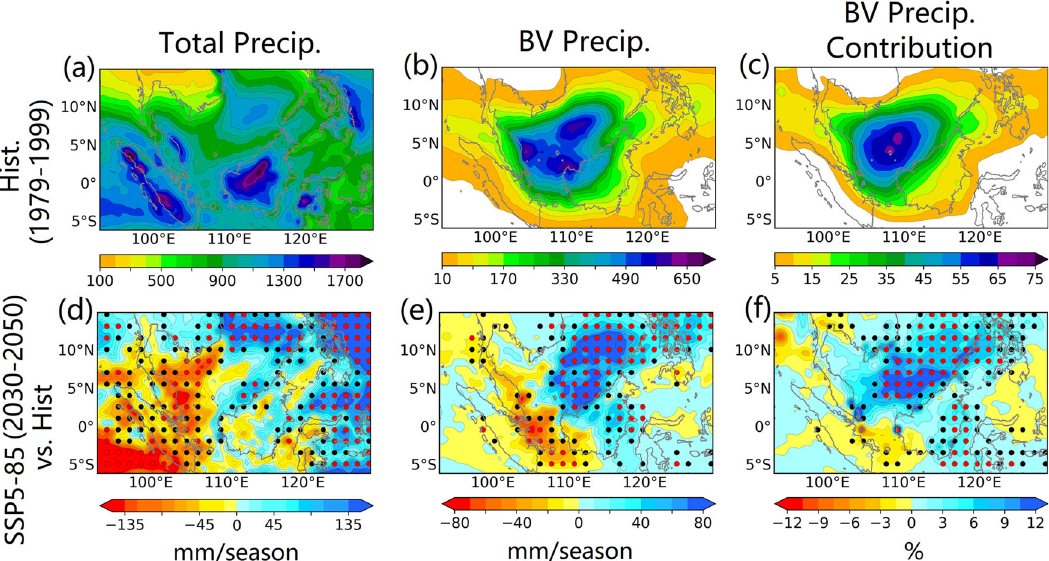
Fig. 2 Spatial distributions of the total precipitation amount, accumulated BV-associated precipitation and the fractional contribution of BVs to total precipitation during ONDJFM. a – c Ensemble mean of historical simulations (1979 – 1999). d – f Ensemble mean of the near-future simulations under SSP5-85 (2030 – 2050). g – i Ensemble mean of the projected absolute changes for SSP5-85 relative to the historical period. Stippling indicates statistical signi fi cance at con fi dence levels of above 90% (black) and 95%